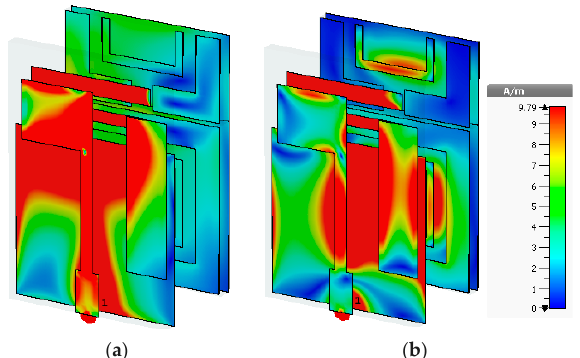
Figure 17. Surface current distribution of the AMC-backed antenna: ( a ) at 2.45 GHz, ( b ) at 5.8 GHz.